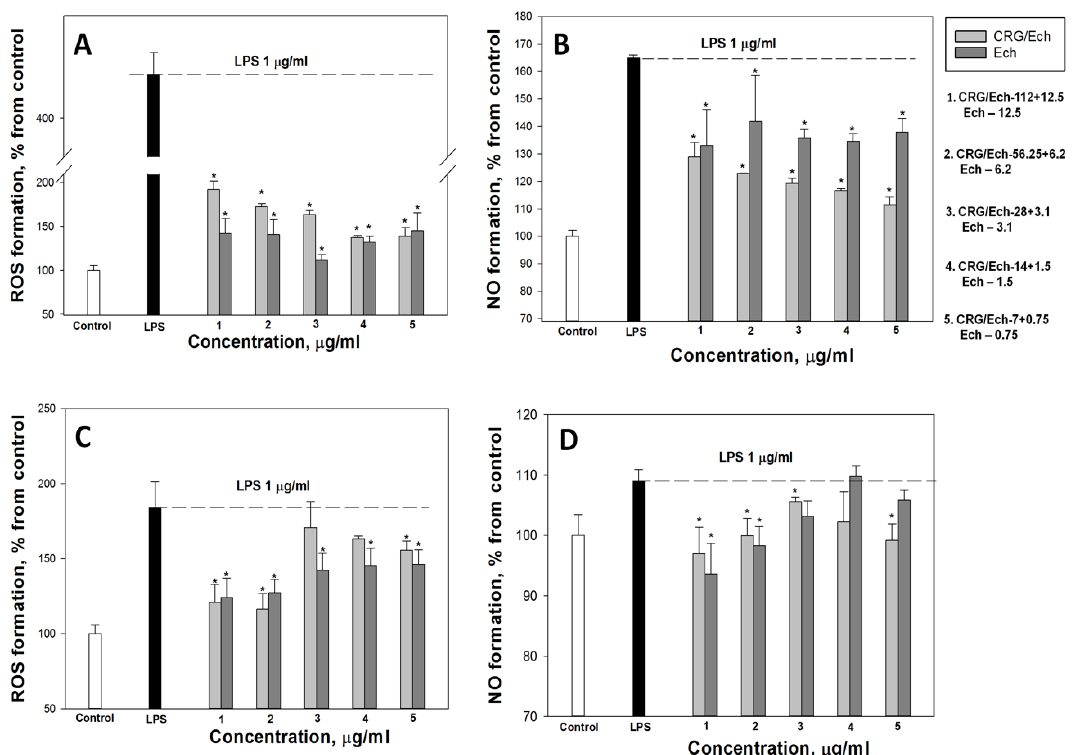
Figure 4. Effects of the CRG/Ech or Ech on intracellular ROS and NO formation in the murine macrophages cell line RAW 264.7 and peritoneal macrophages. The effects of the CRG/Ech or Ech on ROS formation into RAW264.7 cells ( A ) and peritoneal macrophages ( C ) treated by 1 µ g/mL LPS. The effects of the CRG/Ech or Ech on NO formation into RAW 264.7 cells ( B ) and peritoneal macrophages ( D ) treated by 1 µ g/mL LPS. Cells were incubated with CRG/Ech or Ech for 24 h at 37 ◦ C, then 24 h with LPS. The data are shown as the means ± SE; *— p < 0.05. Table 1. The effect of CRG, Ech and CRG/Ech on some physiological parameters in mice intoxicated with E. coli LPS. Organo-Somatic Index, % Groups Liver Thymus